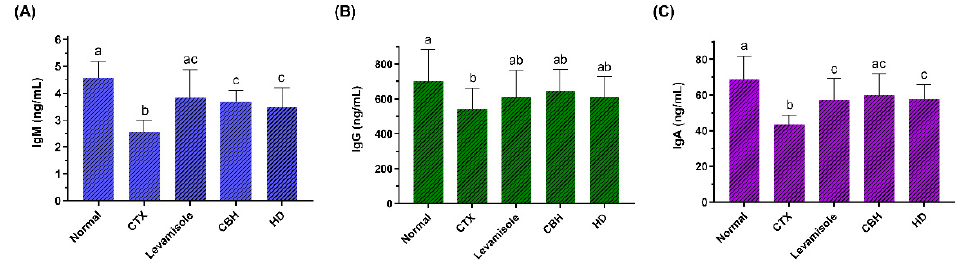
Figure 3. The effect of CHB and HD on the IgM ( A ), IgG ( B ), and IgA ( C ) content in the serum of CTX-treated mice. Data are presented as means ± SD ( n = 10). Different letters for the same index among the groups represent significant differences at p < 0.05.